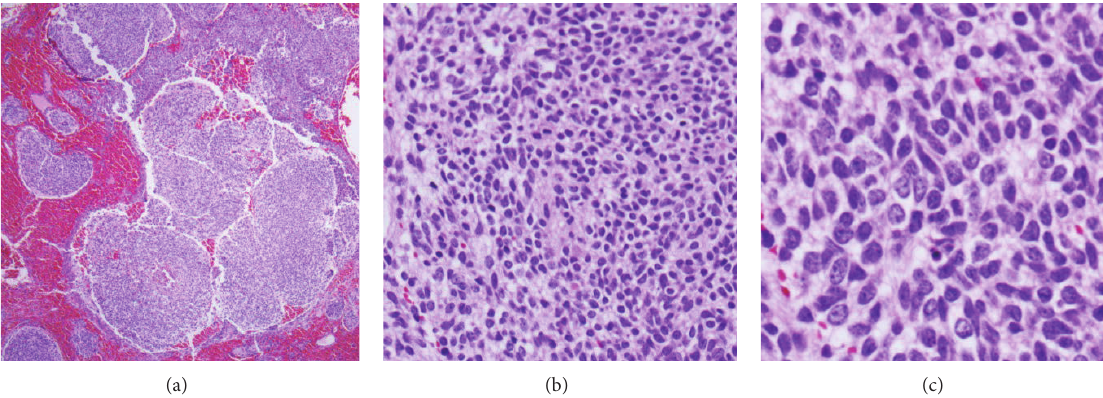
Figure 3: Histologic features of tumor in the left inguinal lymph node. (a) Neuroblastoma component with nodular growth pattern. (b) Each nodule is composed of primitive neuroblasts with scant amount of neuropil. (c) Neuroblasts with salt and peppery nuclei and low MKI (hematoxylin-eosin, original magnification × 40 (a); original magnification × 200 (b); original magnification × 400